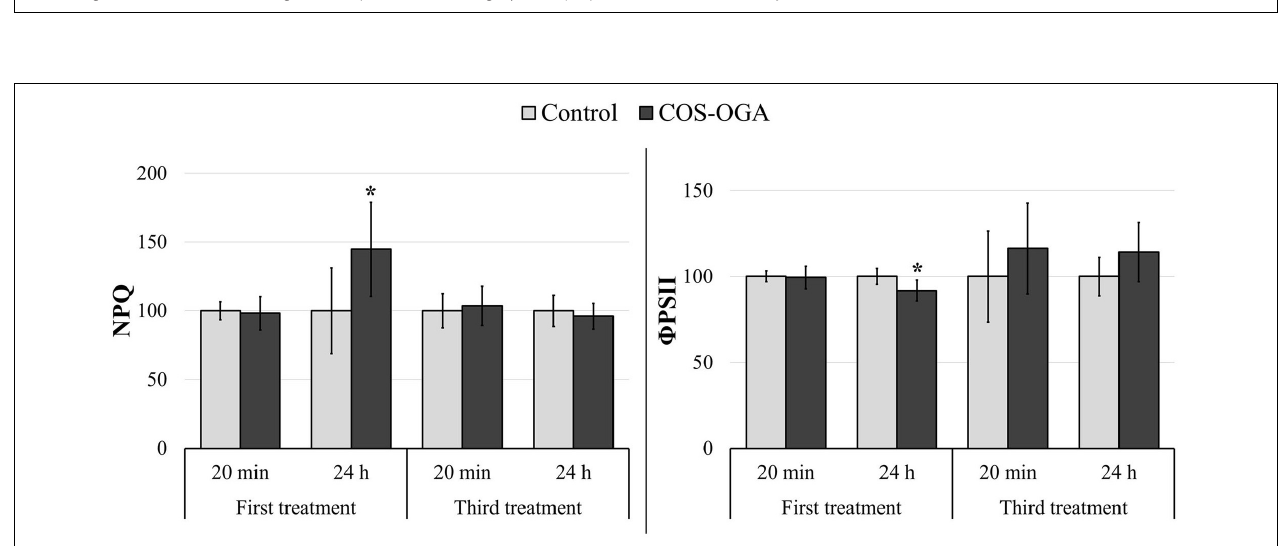
FIGURE 2 | Enriched cellular components (Gene Ontology) in upregulated differentially expressed genes (DEGs) of tomato leaves after three sprayings with chitooligosaccharides–oligogalacturonides (COS-OGA; 62.5 mg/l; based on Plaza project, Dicot 4.5). Tomato leaves were harvested 24 h after the third treatment. Enriched cellular components (Gene Ontology) were identified based on hypergeometric test with Bonferroni correction ( p values < 0.001). The left axis corresponds to the log 2 enrichment fold. The right axis represents the − log 2 ( p value) represented on the chart by the confidence.